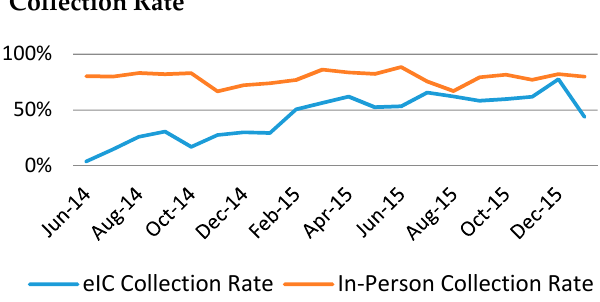
Figure 4. Sample collection rate by in-person consent (red) and eIC (blue) from 1 June 2014 through December 2015.